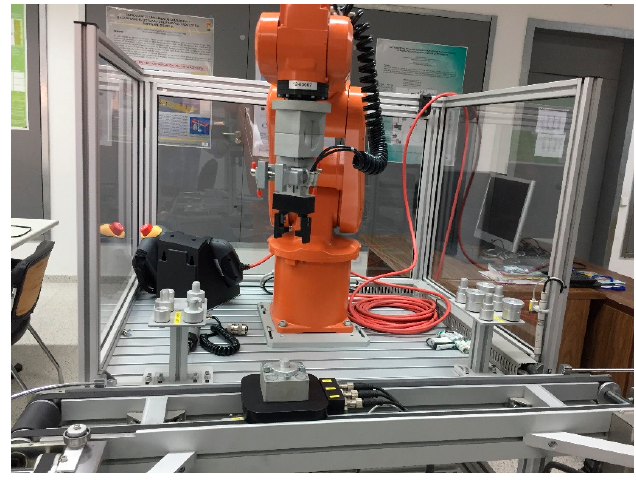
Figure 4. Station FMS-207: Robotized screwing.